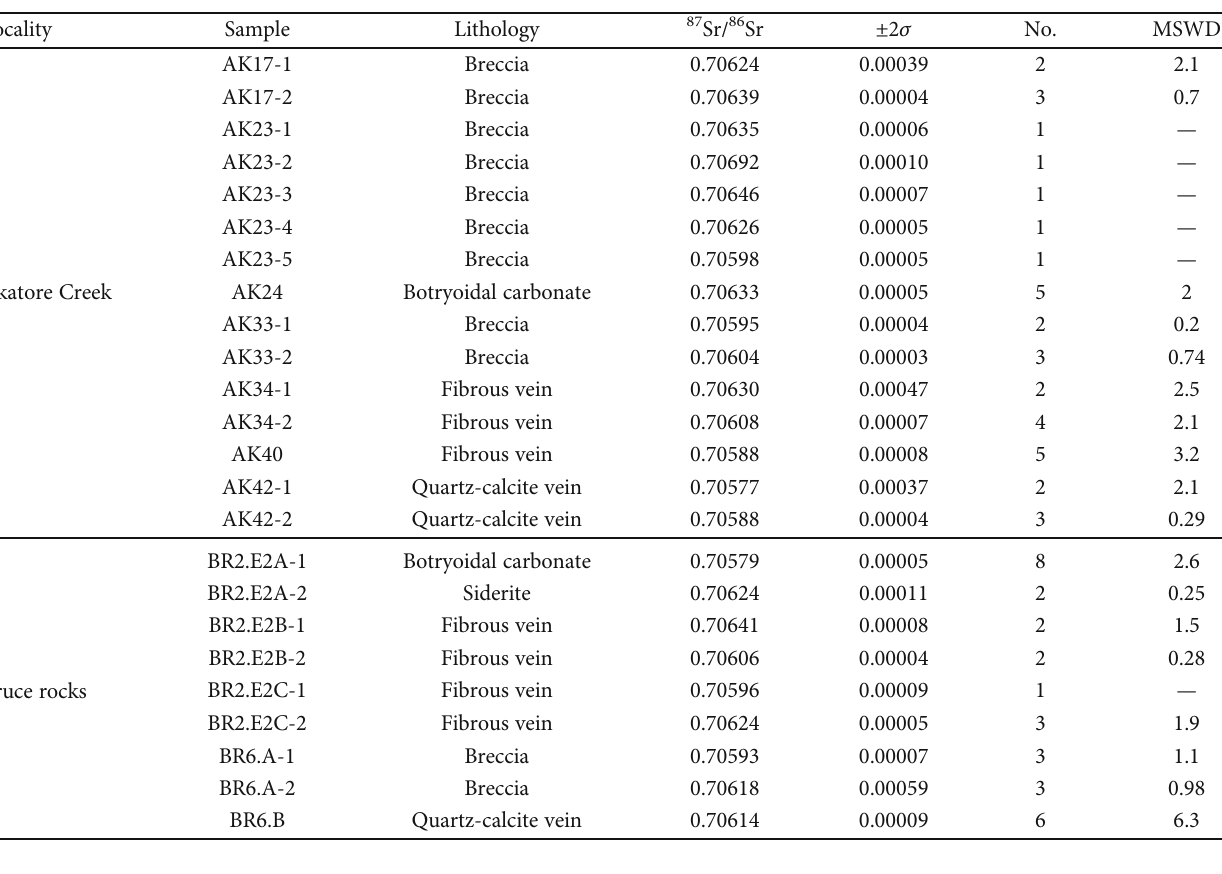
Table 4: In situ average 87 Sr/ 86 Sr isotope ratios with error and mean square weighted deviation (MSWD) values from the di ff erent carbonate types.